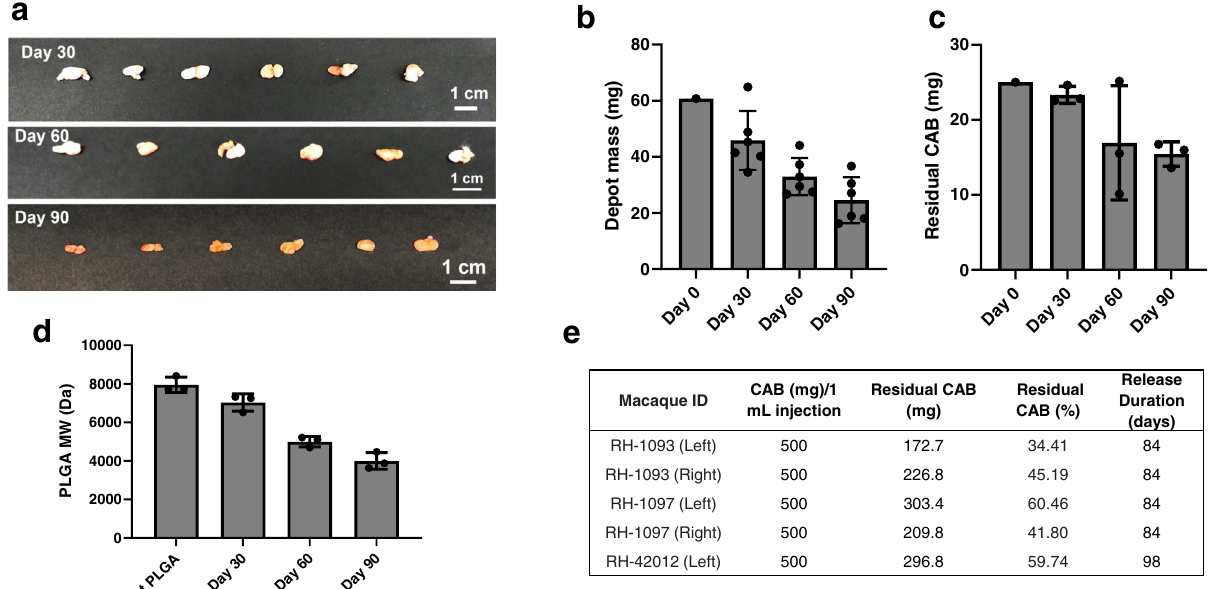
Fig. 7 | CAB ISFI biodegradation and residual drug quanti fi cation in BALB/c miceandrhesusmacaques.a ImageofCABISFIsretrievedfromBALB/cmice30-, 60-, and 90-days post-injection. b CAB ISFI masses 30-, 60-, and 90-days post- injection in mice (average ± standard deviation; n =6/timepoint) compared to initial ISFI mass (day 0) from a 50 µ L injection volume (60.75mg). Day 0 masses were calculated based on a 50 µ L injection volume and using the density of the formulation (1.215g/mL) to determine approximate mass at injection.